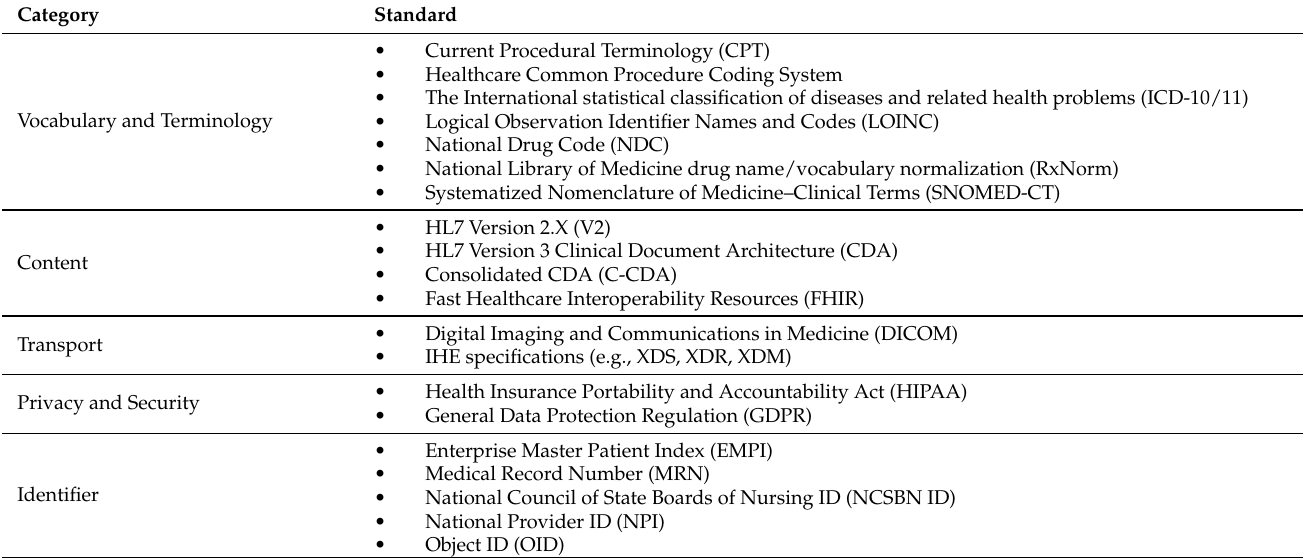
Table 1. Healthcare